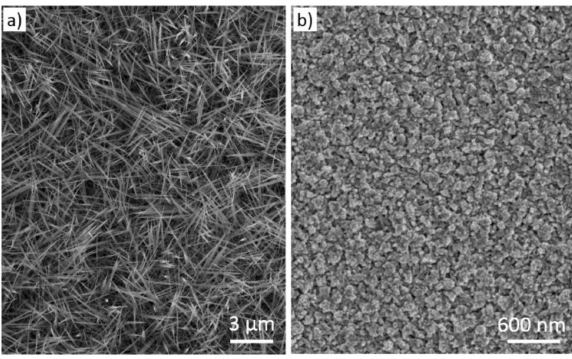
Figure 3. Scanning electron microscope images of ( a ) nanowire mat ( b ) NP films. Adapted from